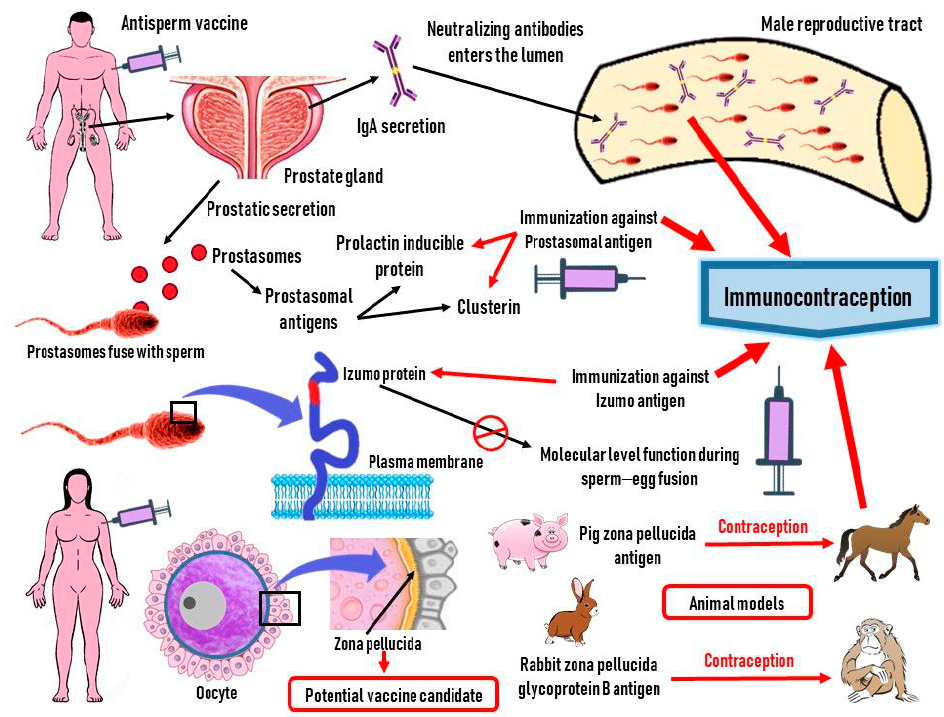
Figure 3. Mechanism of action that can produce successful immunocontraception along with potential antigens that can be used as vaccine candidates are represented.